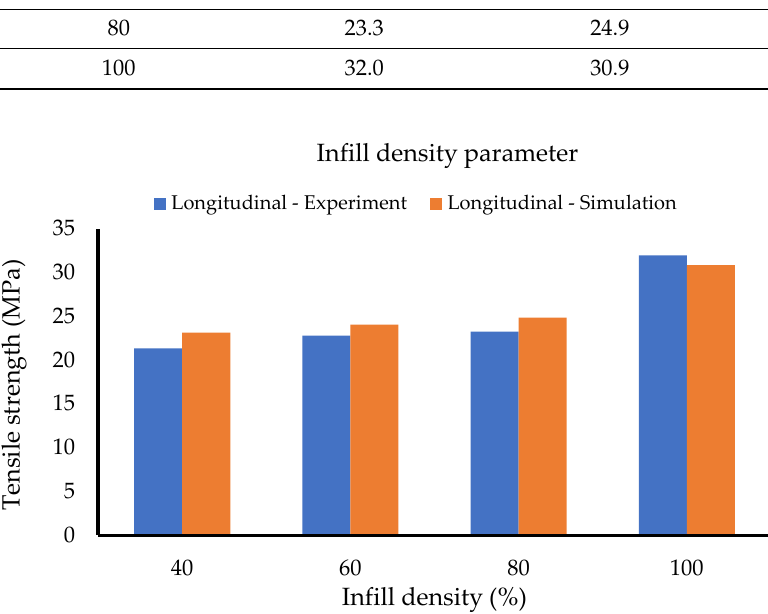
Table 5. Modelling results for the infill density set (Method 1).